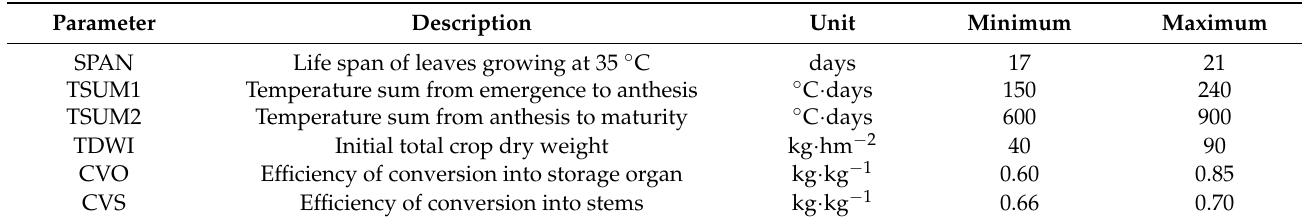
Table 2. Main adjustable parameters of WOFOST in predicting oilseed rape